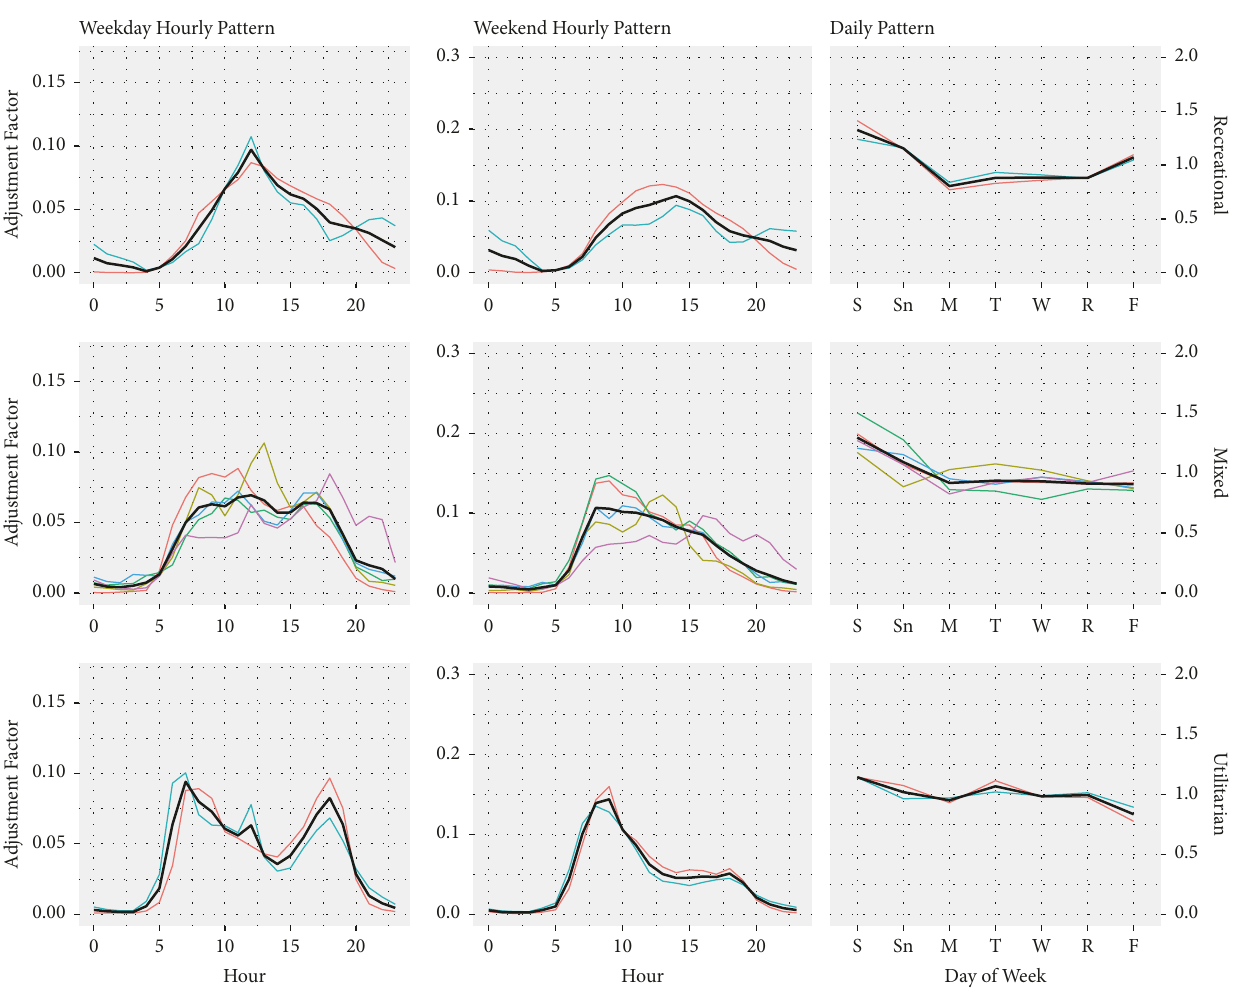
Figure 5: Clustering result of long-term pedestrian counters classified into three groups (Recreational, Mixed, and Utilitarian).